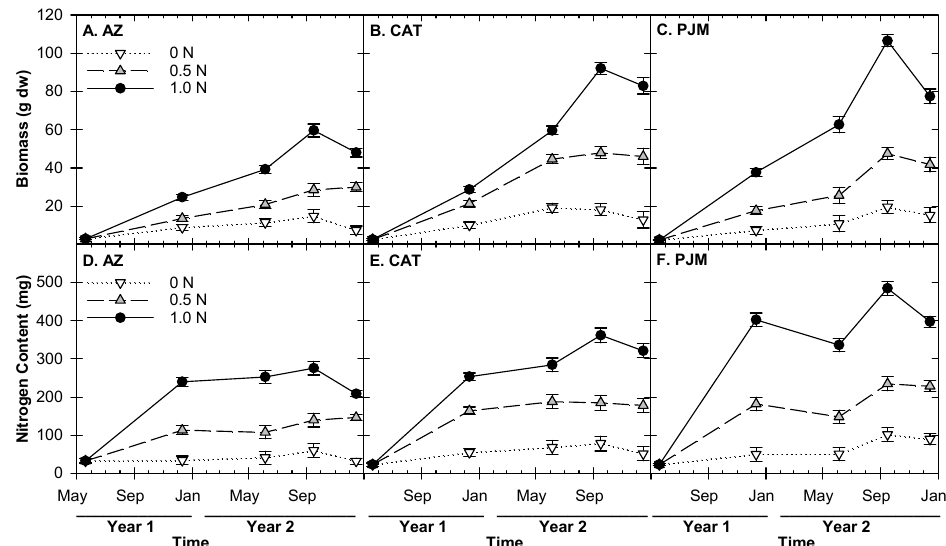
Figure 1. Total biomass (dry weight; dw) and N content of ‘Gibraltar’ (AZ) ( A , D ), ‘Catawbiense Album’ (CAT) ( B , E ), and ‘P.J.M.’ (PJM) Rhododendron ( C , F ). In Year 1, plants were grown in soilless media with N-free fertilizer (0 N) or N-free fertilizer plus 7 (0.5 N) or 14 (1.0 N) mg N per day from NH 4 NO 3 and irrigated once daily to 100% (W1) or 50% (W2) container capacity or twice daily to 100% container capacity (W3). In year 2, the plants were transplanted into soil. Data are pooled across irrigation treatments, and error bars represent least significant differences at p ≤ 0.05.